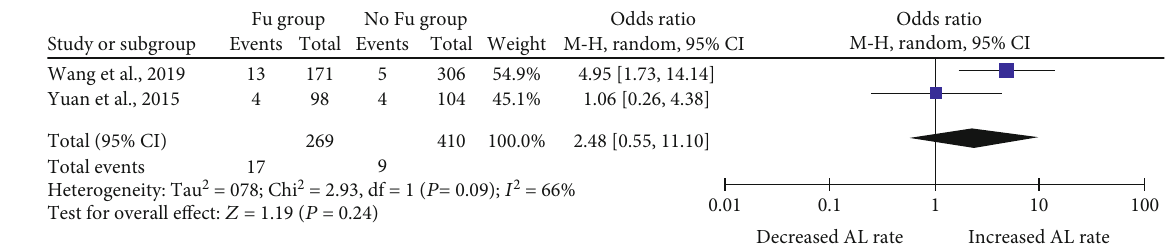
Figure 3: Fu implantation for IC